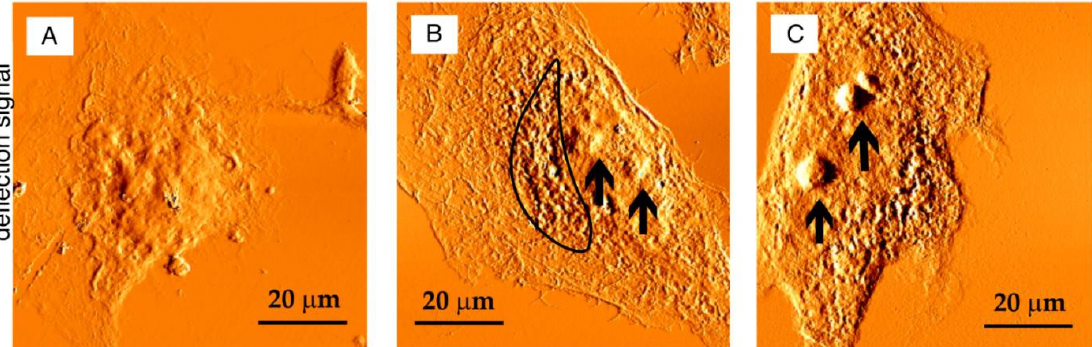
Figure 3. AFM images of cellular imprints of fixed HCC38 breast cancer cells saved in PMMA photoresists by soft X-ray contact microscopy. Images were obtained with SXR exposures of ( A ) 400, ( B ) 600, and ( C ) 800 pulses. The nucleoli of the nuclei are indicated by arrows and the endoplasmic reticulum, vacuoles, and mitochondria are outlined with a frame. Imprints were recorded by AFM working in contact mode (Xe120, Park Systems Suwon, South Korea) with OTR4 cantilevers (0.02 N/m, Bruker, Camarillo, CA, USA). Scan size of 80 × 80 μm 2 . A deflection signal is presented. Reproduced with permission from Osuchowska et al. [44] .